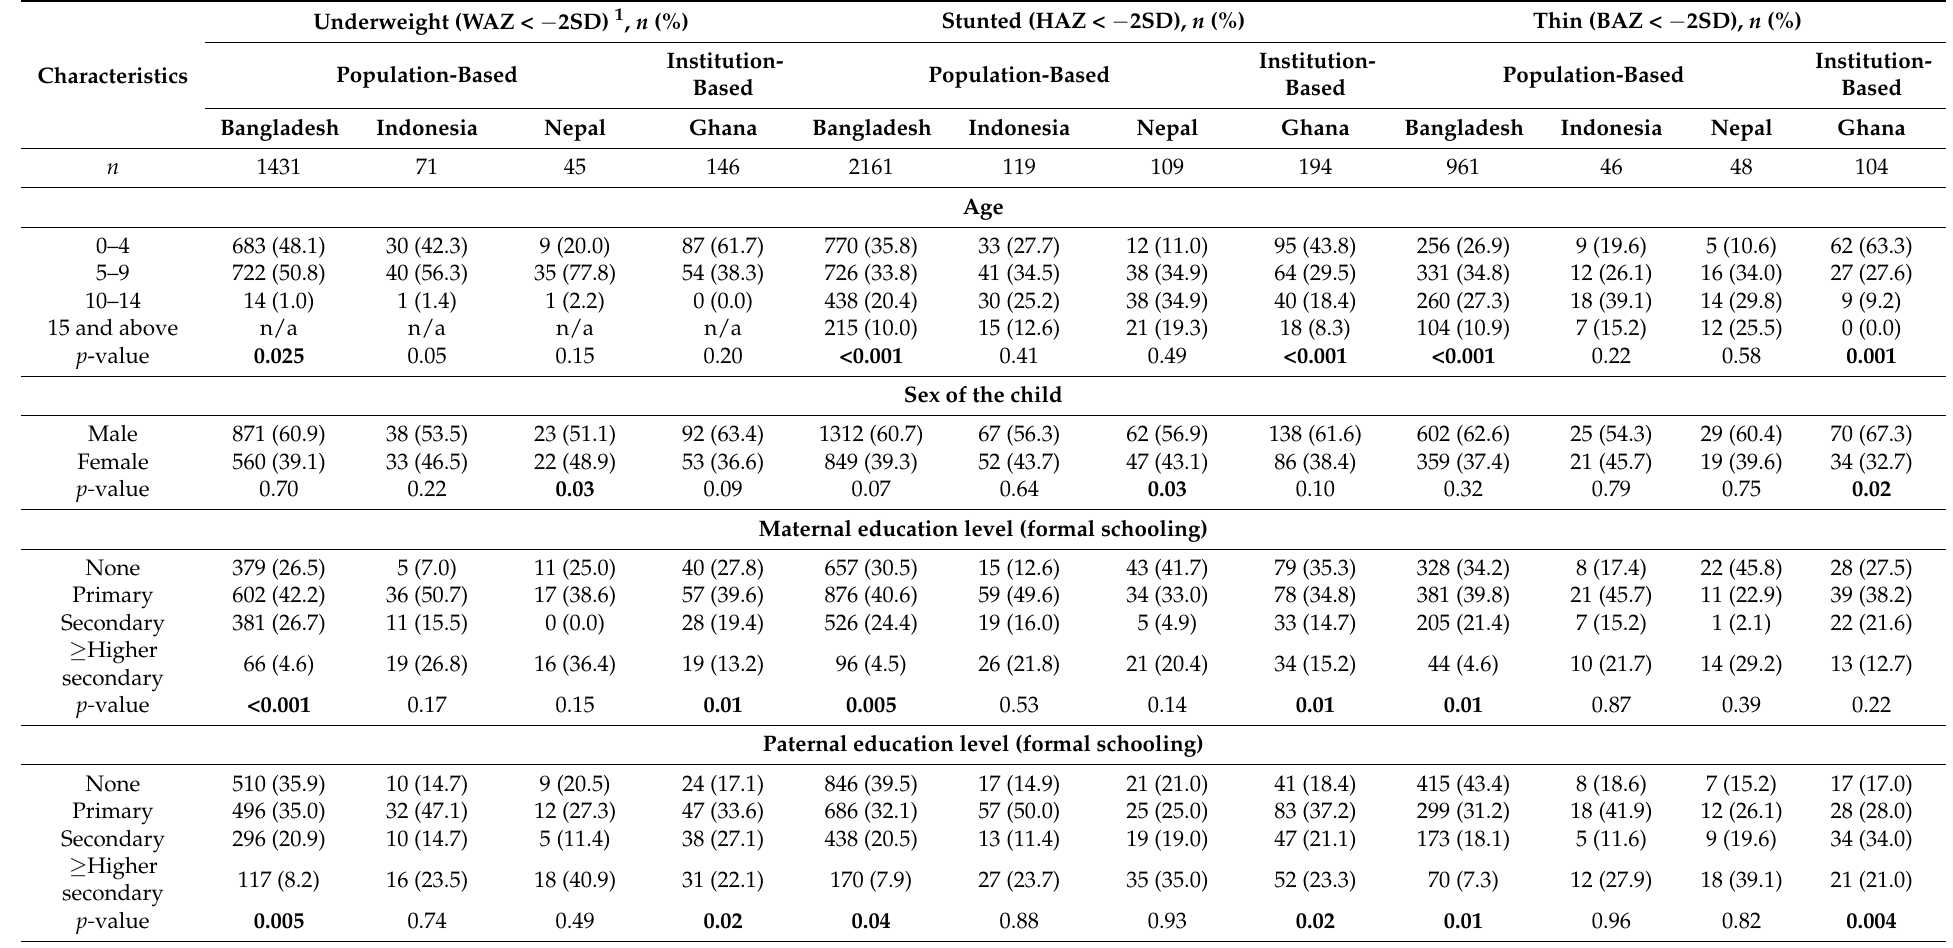
Table 2. Nutritional status of children with CP registered into the GLM CPR according to their sociodemographic characteristics.